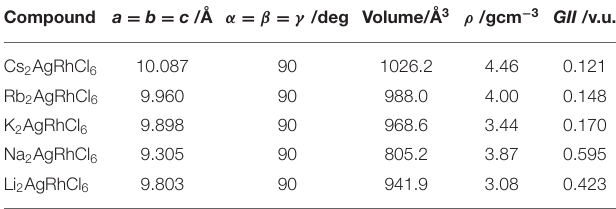
TABLE 1 | Selected geometrical (lattice, volumetric, density, and stability) properties of A 2 AgRhCl 6 (A Cs, Rb, K, Na, Li) obtained with SCAN- rVV 10. =